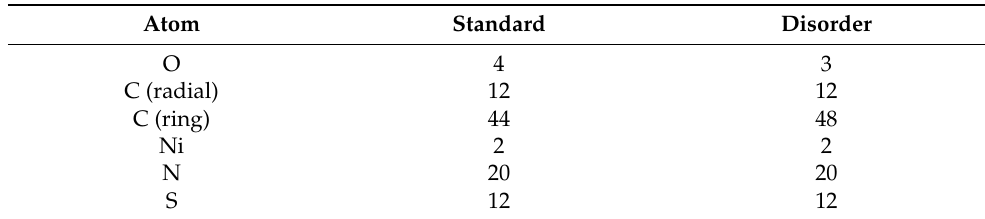
Figure 7. ( a ) Atomic distribution inside the primitive cell obtained from Mercury for all atoms except hydrogen atoms ( b ) disorder of the cyclohexylammonium six carbon atoms.